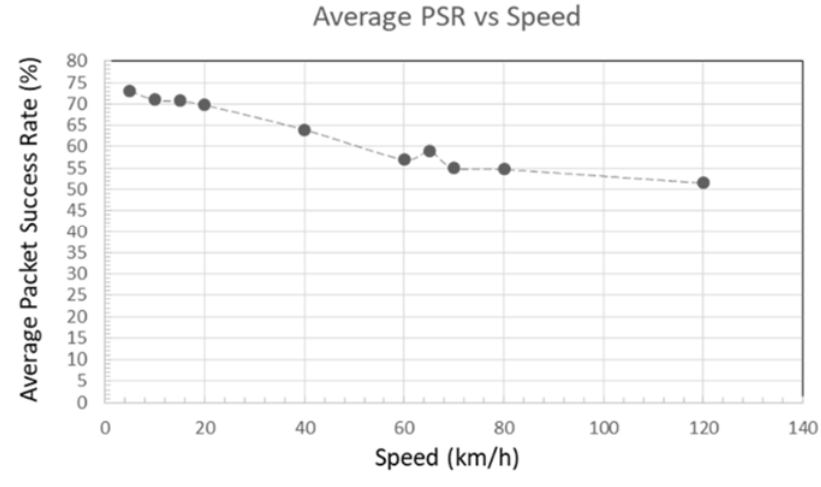
Figure 27. Average Packet Success Rate vs. Speed.